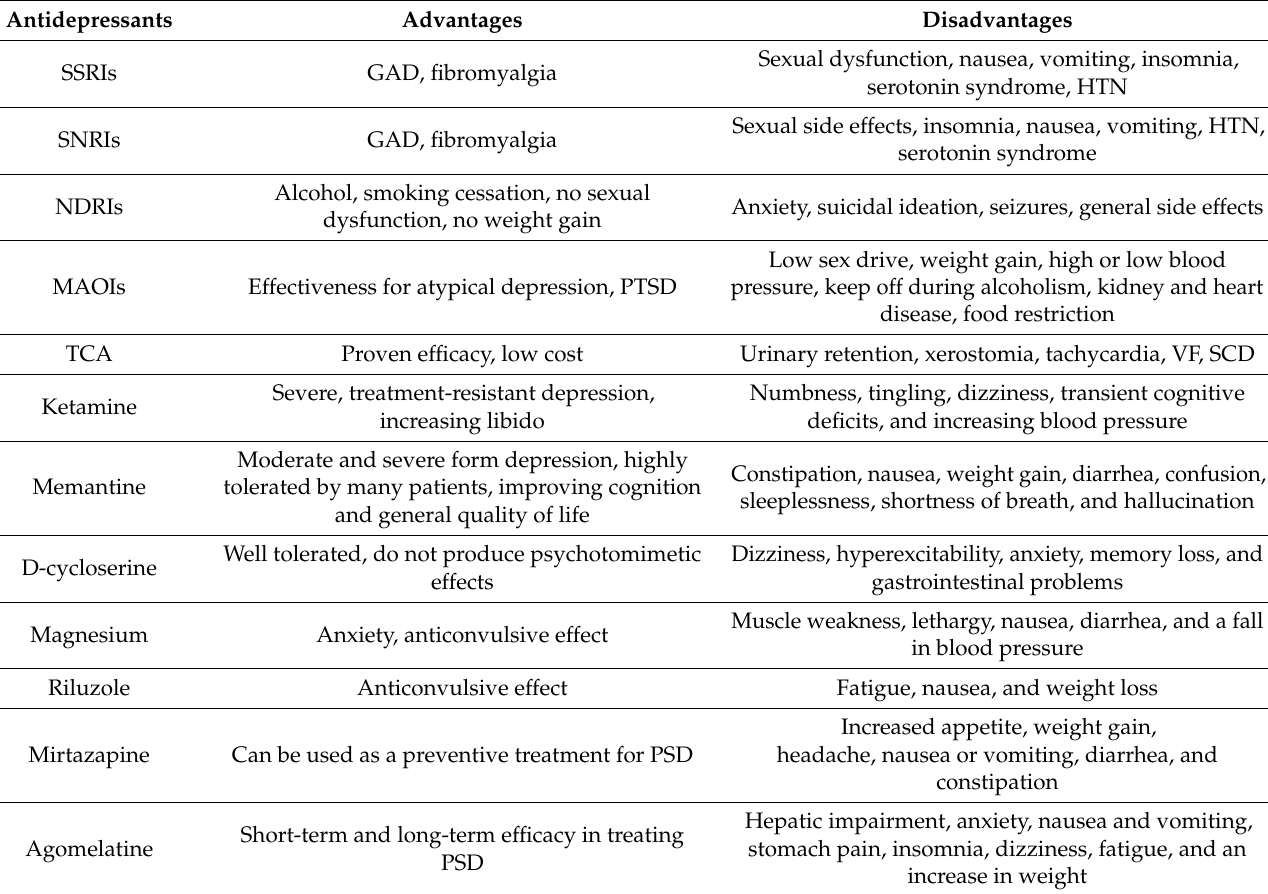
Table 2. The table of advantages and disadvantages of various antidepressant